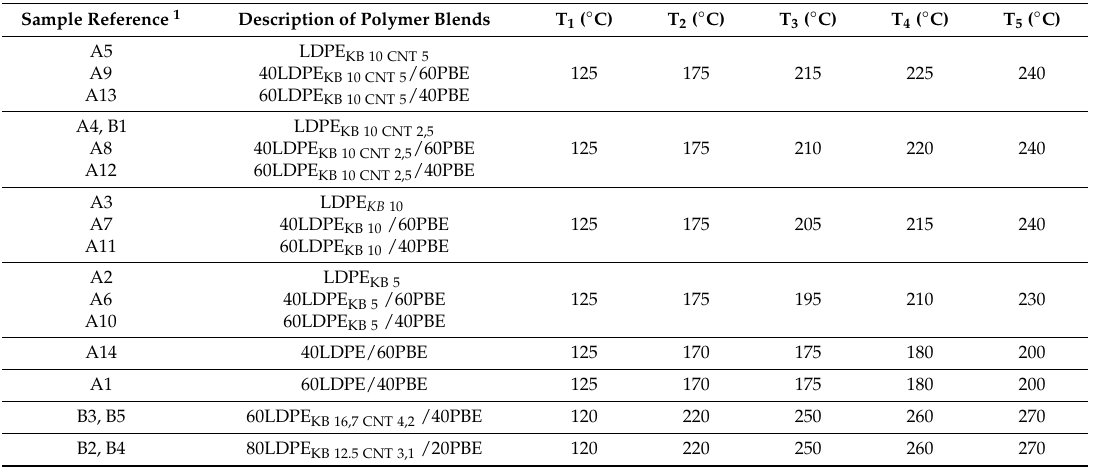
Table 3. Temperature profiles ( ◦ C) of the extrusion of the LDPE-based CPCs and polymer blends. Sample Reference